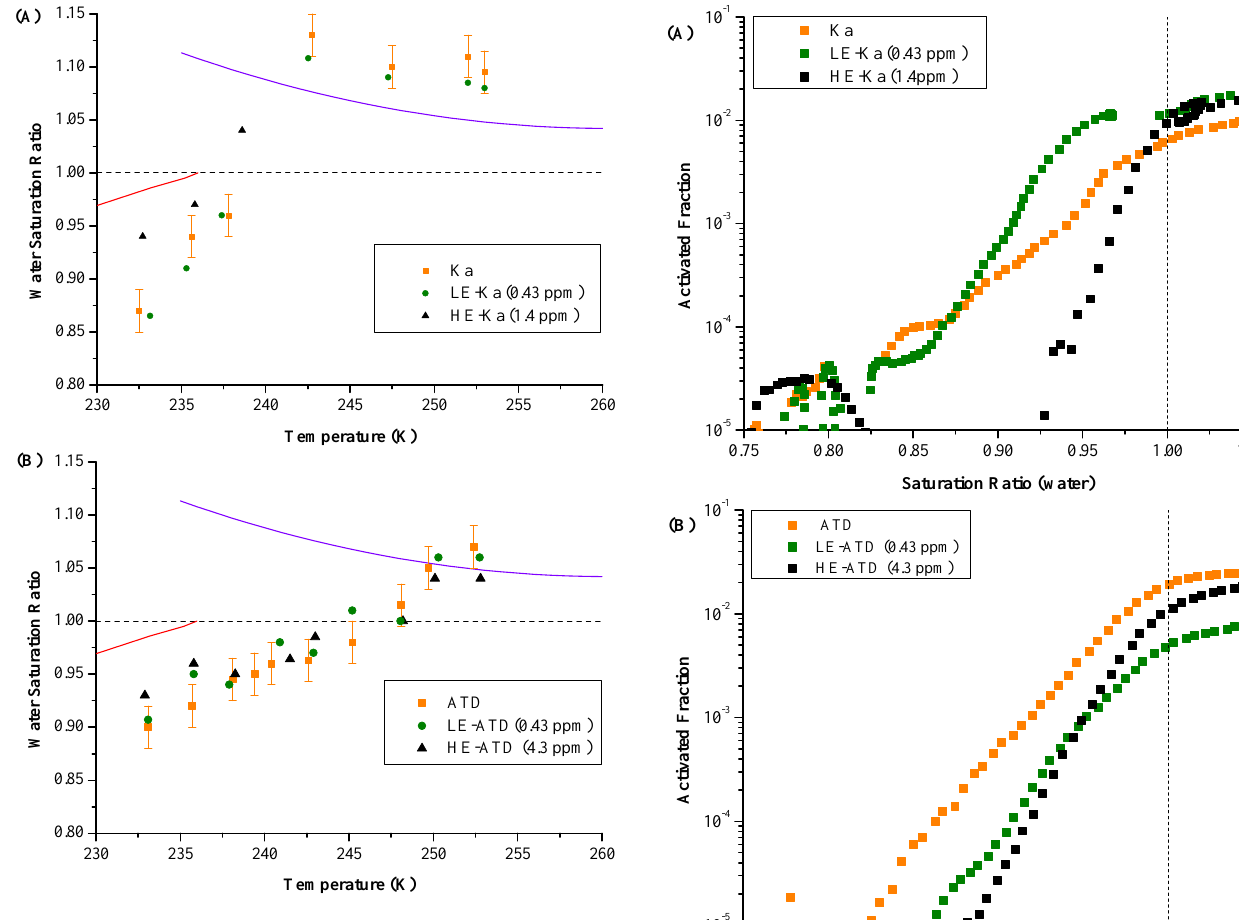
Fig. 5. Ice activated fraction for 0.1% of the particle population forming ice as a function of temperature in the deposition mode (A) Ka and (B) ATD. Dashed line: RH w = 100%, red line: freezing of 0.1% 300nm aqueous ammonium sulfate particles in 10s (Koop et al., 2000; DeMott et al., 2009), purple line: water drop survival line for PINC.